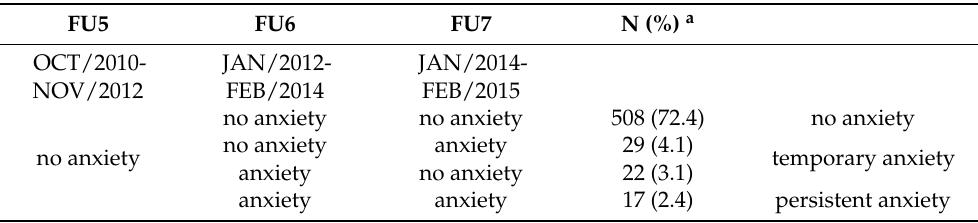
Table 4. Course of anxiety from follow-up wave 5 to 7.